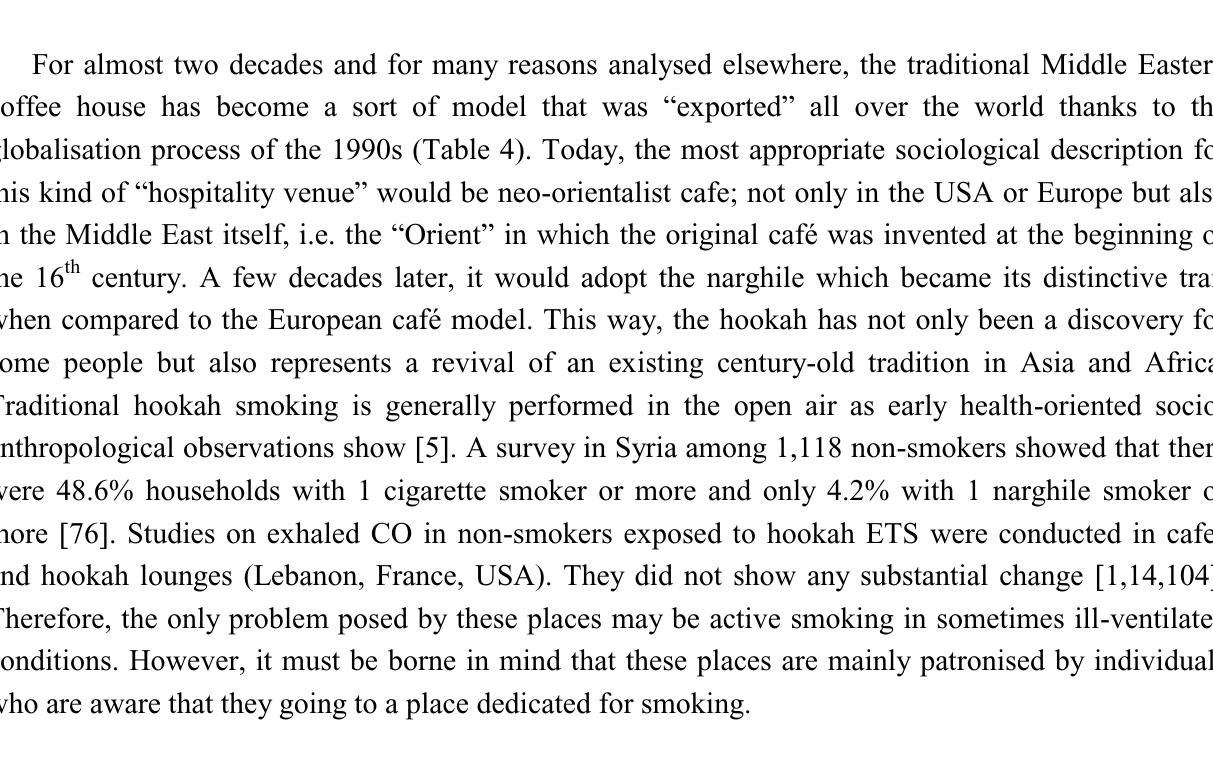
Table 4. The 15 Reasons behind the World Upsurge in Hookah (Narghile, Shisha) Smoking. Originally published in the 4 th part of the Tetralogy on Hookah and Health: Chaouachi K. Narghilé: un problema di Sanità Pubblica